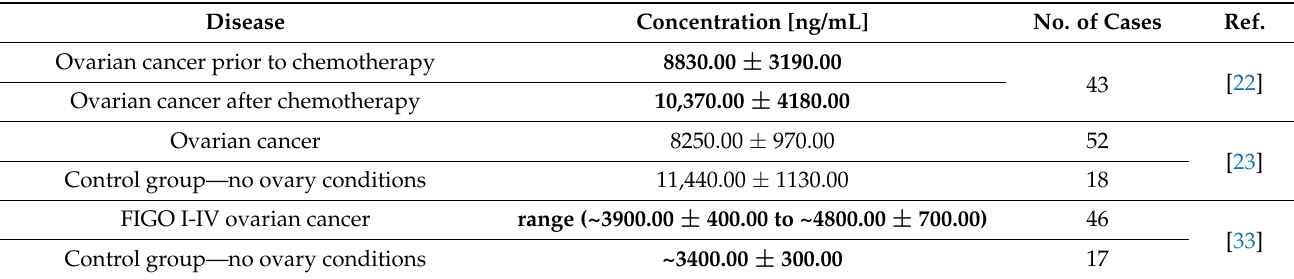
Table 2. Concentration of adiponectin in blood (plasma/ serum ).